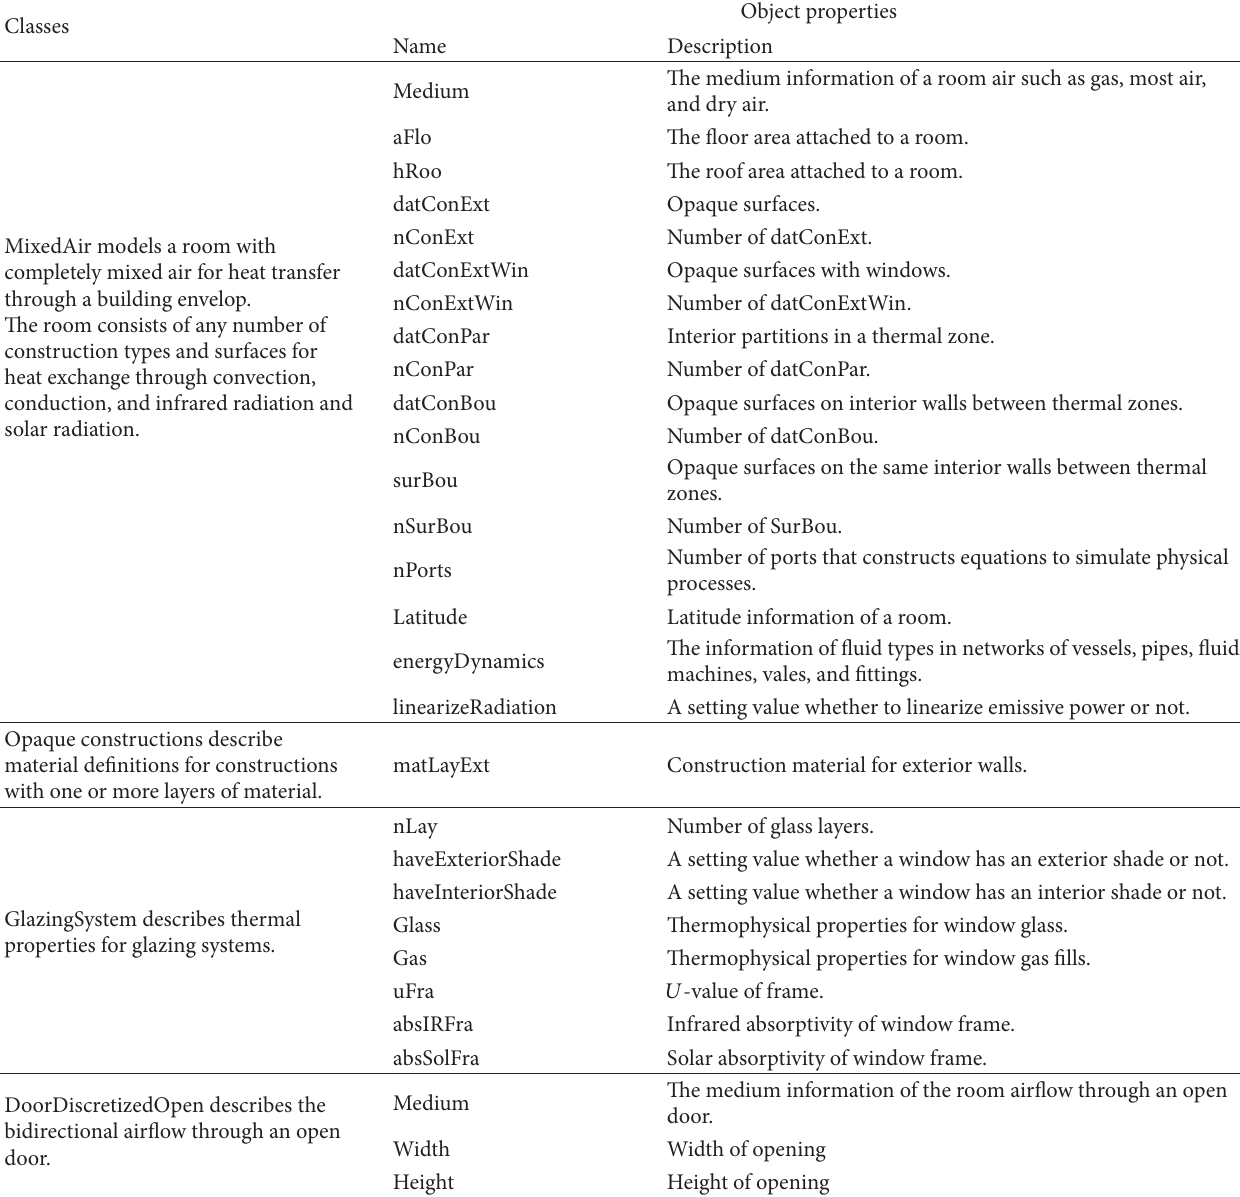
Table 1: Classes and parameters adapted from LBNL Modelica Buildings library